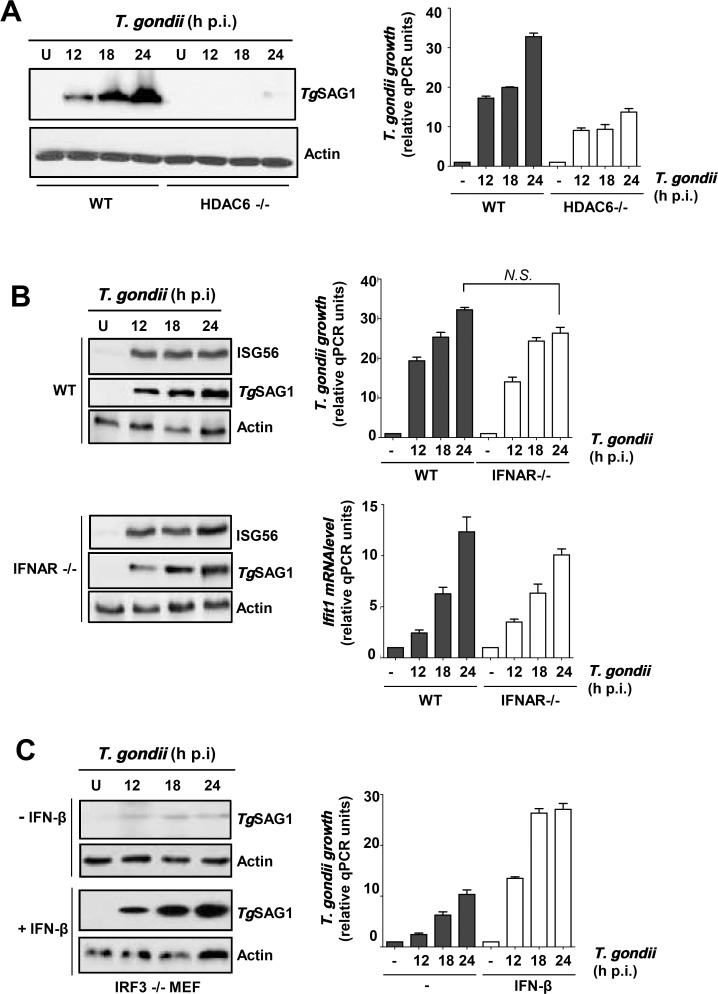
Requirement of IRF3-induced host genes for T. gondii replication.
A, Infection and immunoblotting was performed with HDAC6 KO and wild type MEF cells. B, MEF cells (wild type or IFNAR KO) were infected with T. gondii and the indicated proteins were measured by immunoblotting. C, T. gondii growth measured in IRF3 KO MEF cells; where indicated, recombinant murine IFN-β (2,000 U/ml, R&D Systems) was added, and parasite was added 6 h later. Immunoblotting was performed as above. Where shown, parasite growth was also quantified by qPCR of genomic DNA, and ISG56 (Ifit1) mRNA was quantified by qRT-PCR as described before [66].